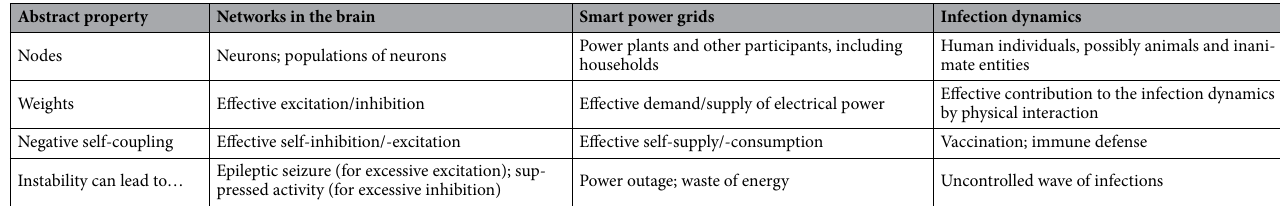
Table 3. Analogies between abstract networks and real-world applications. Three examples from different fields (neuroscience, electrical engineering, and epidemiology) are